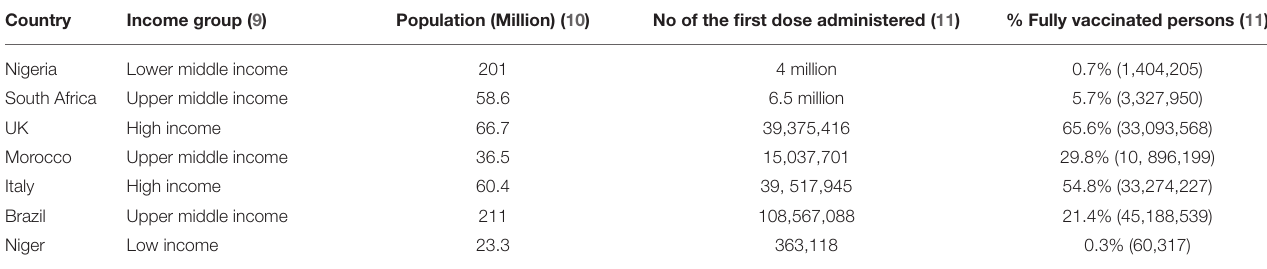
TABLE 1 | Status of COVID-19 vaccinations in selected countries across the world as of 6th August 2021.